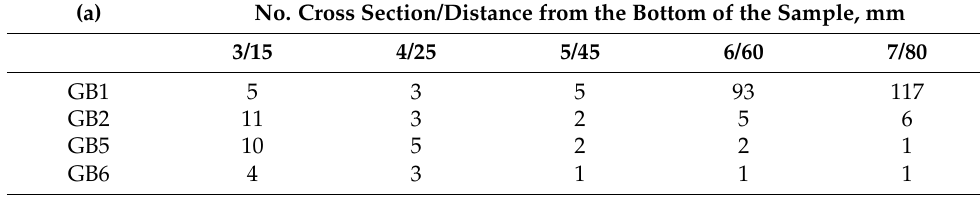
No. Cross Section/Distance from the Bottom of the Sample,